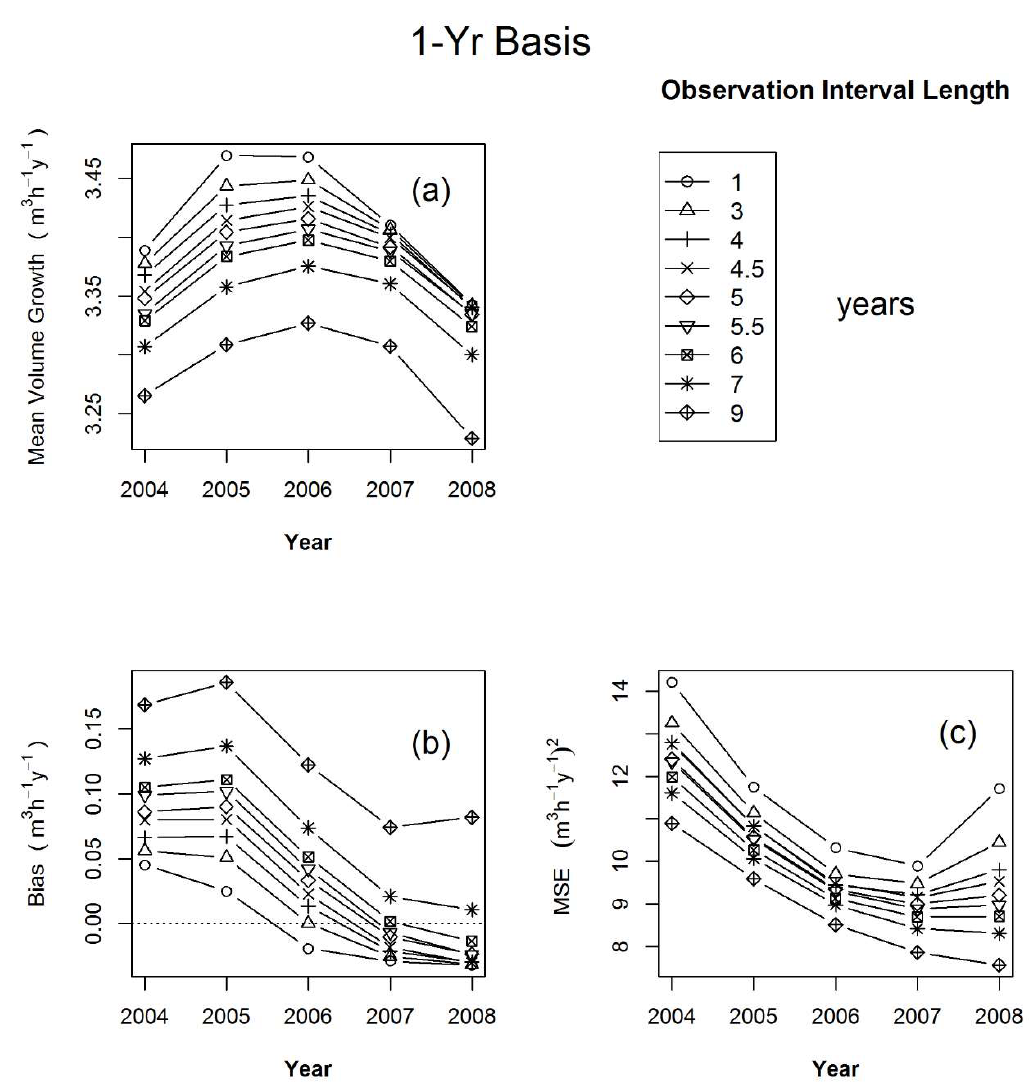
Figure 3. The simulation mean volume growth ( a ), the simulation mean bias ( b ), and the simulation mean of mean-squared errors ( c ) for Estimand 1 (the annual mean) for the means from each of the nine interval lengths of 1, 3, 4, 4.5, 5, 5.5, 6, 7, and 9 years, applied to the years 2004–2008, from 100 samples of size 1000 from each of the 125